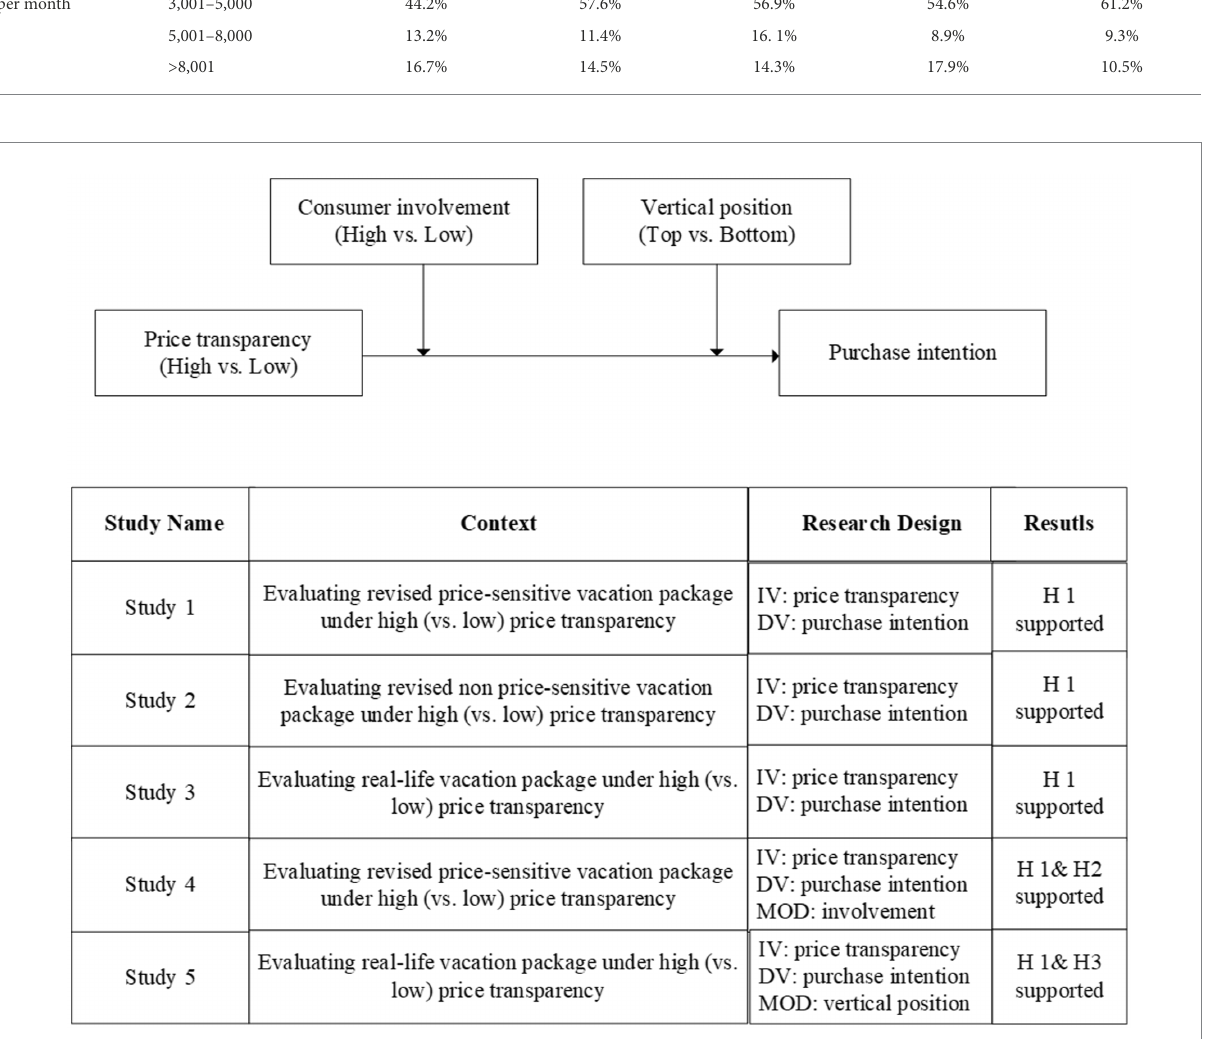
FIGURE 1 Theoretical framework and summary of empircal